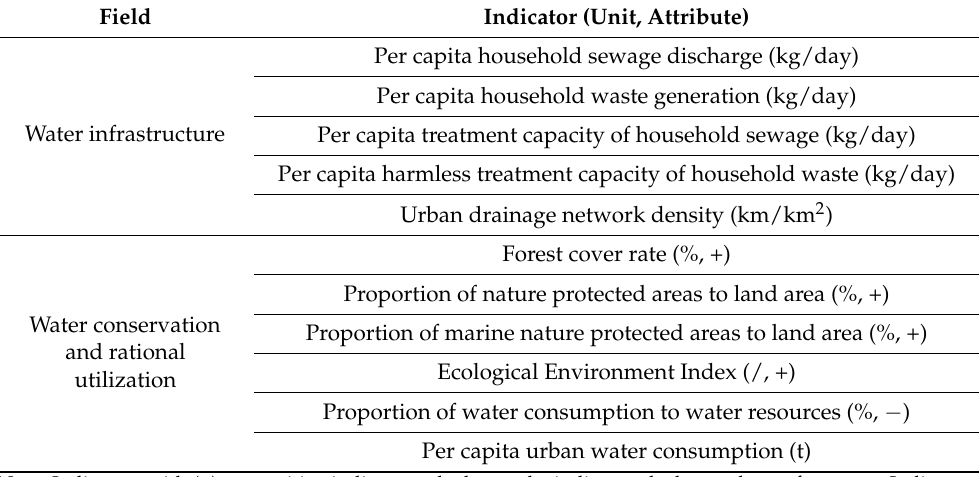
Table 2. Cont. Field Indicator (Unit, Attribute) Per capita household sewage discharge (kg/day) Per capita household waste generation Water infrastructure